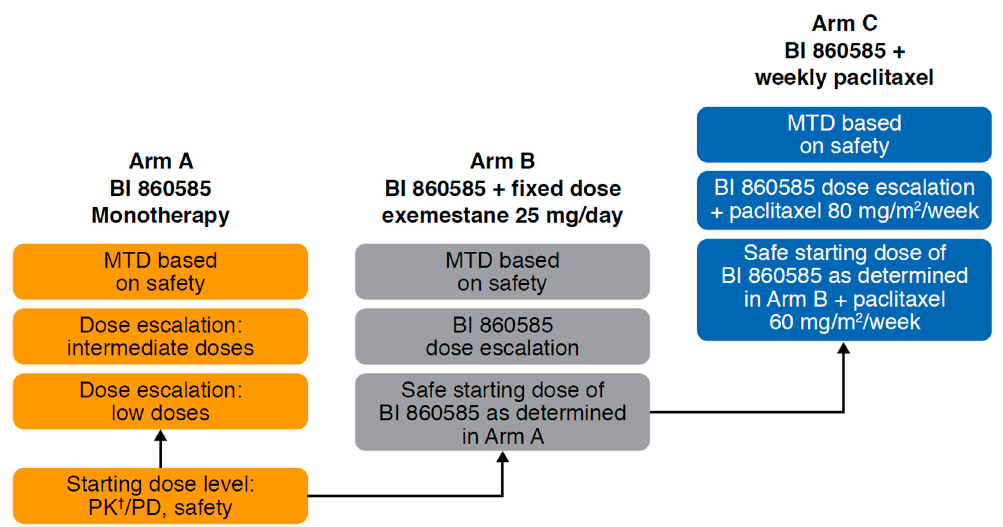
Figure 1. Study design. Abbreviations: MTD: Maximum tolerated dose; PD: Pharmacodynamics; PK: Pharmacokinetics. † Including food effects.